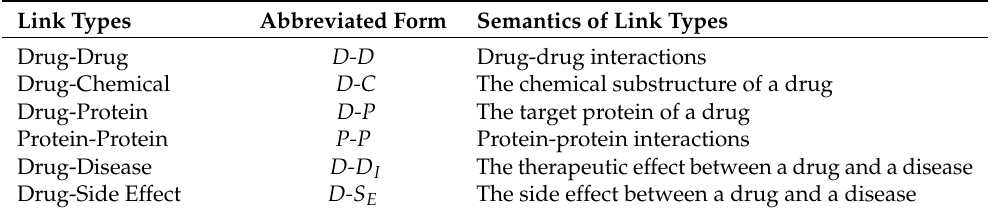
Table 2. Semantics of link types in the drug heterogeneous information network